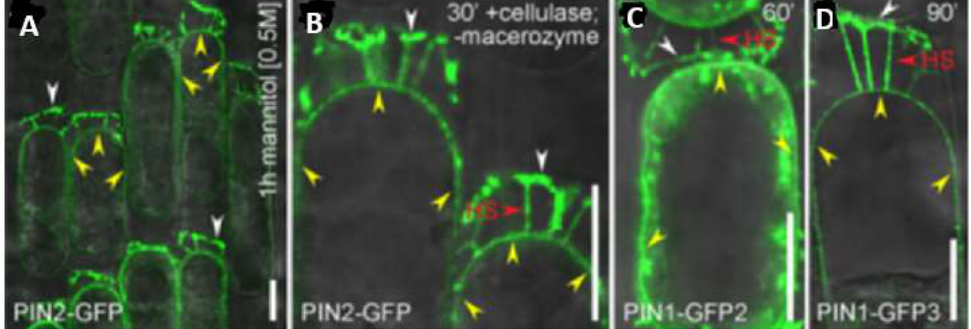
Figure 5. PIN proteins maintain their polarity at the cell wall of plasmolysed cells. Plasmolysis shows that apical (PIN2-GFP and PIN1-GFP-3) and basal (PIN1-GFP-2) proteins remain attached to the cell wall by their polar domains. ( A–D ) Note—yellow arrowheads = nonpolar PIN-GFP signal at the plasma membrane. HS = Hechtian strands with PIN-GFP-connections to the wall. White arrowheads = a strong persistent PIN-GFP signal at the cell wall–plasma membrane interface. Scale bars = 10 µm. Reprinted from Figure 4 of [91].